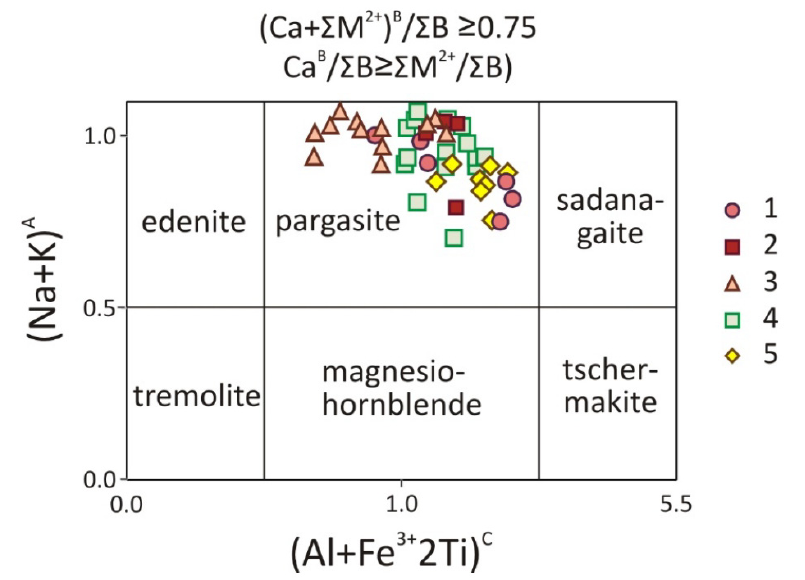
Figure 13. Amphiboles in (Na+K) A –(Al+Fe 3+ +2Ti) C diagram after [31]. 1–3 = amphiboles from dolerite (1), pyroxenite (2), and skarned pyroxenite (3) in the pyroxenite fragment with remnant dolerite; 4,5